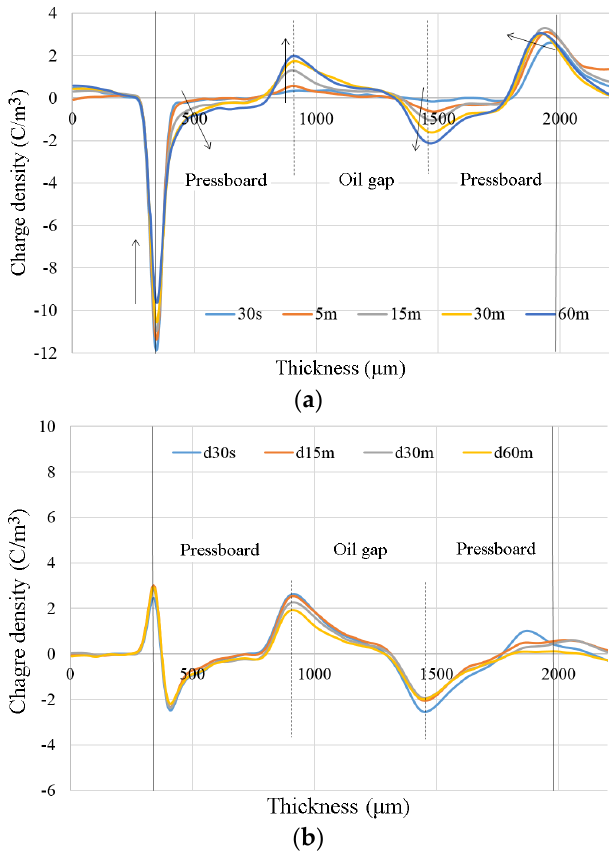
Figure 24. Volt ‐ on (20 kV/mm) ( a ) and decay ( b ) results in multilayer oil and oil ‐ impregnated Figure 24. Volt-on (20 kV/mm) ( a ) and decay ( b ) results in multilayer oil and oil-impregnated pressboard [50]. pressboard